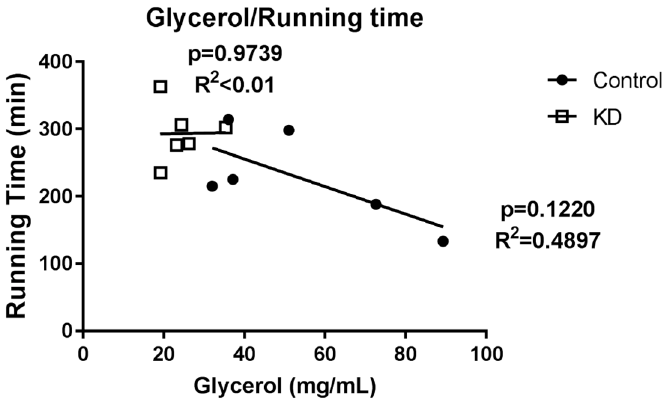
Figure 9. Correlation of plasma glycerol and exercise capacity. No significance was observed.